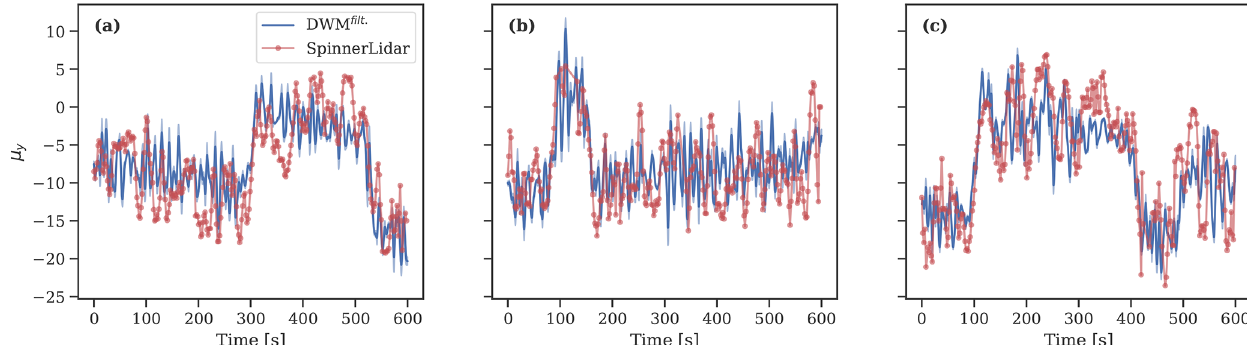
Figure A1. Time series of the wake meandering in the lateral direction observed by the SpinnerLidar (red markers) and those derived from the meandering model of Eq. (4) denoted as DWM filt . (blue lines) under stable ( a ), near-neutral ( b ), and unstable conditions ( c ). The predictions are obtained at 2.5 D behind the rotor. The shaded blue areas indicate the 95% confidence intervals obtained by propagating the uncertainty in the large-scale-eddy